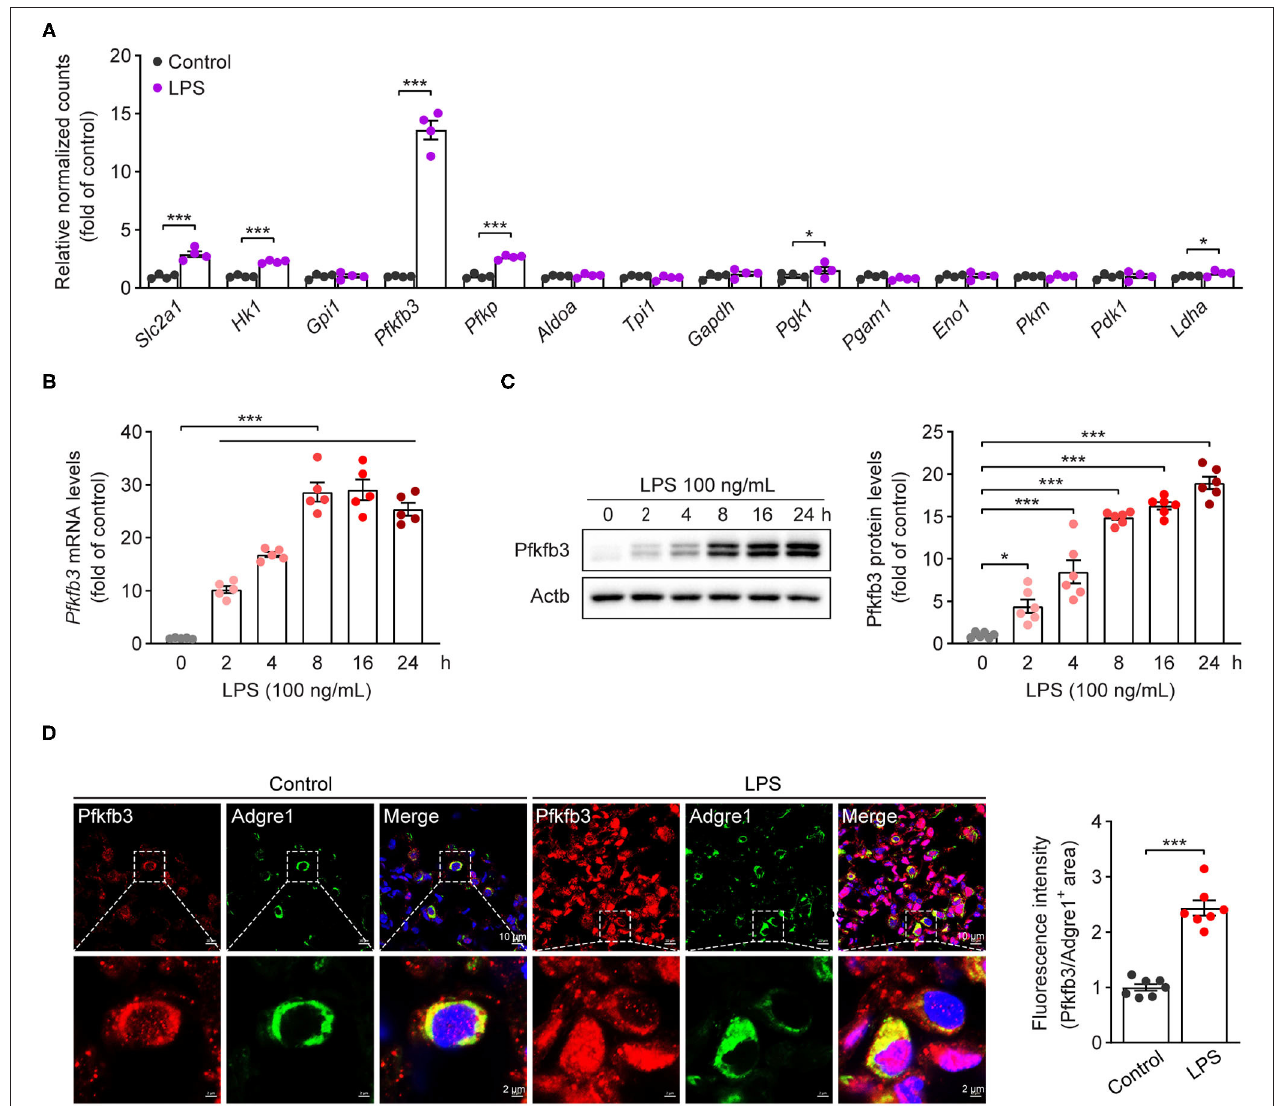
FIGURE 1 | Pfkfb3 expression is upregulated in macrophages treated with LPS. (A) The expression of glycolytic genes in BMDMs treated with LPS (100ng/mL) for 4h, the data are genome mRNA expression profiling data (GSE125036) from the GEO database ( n = 4). (B) qPCR analysis of Pfkfb3 expression in BMDMs treated with LPS (100ng/mL) for the indicated times ( n = 5). (C) Representative Western blot results of Pfkfb3 and Actb in BMDMs treated with LPS (100ng/mL) for the indicated times (left) and relative ratio of Pfkfb3/Actb (right) were quantitated by densitometric analysis of the corresponding Western blots ( n = 6). (D) Representative images (left) of triple immunofluorescence for Pfkfb3 (red), Adgre1 (green) and nuclei (DAPI, blue), and quantification (right) of Pfkfb3 expression in the pulmonary macrophages of control or LPS-treated mice ( n = 7). All data are represented as mean ± SEM, and *** P < 0.001 for indicated comparisons. Unpaired two-tailed Student’s t test for (A,D) and one-way ANOVA with Bonferroni’s post-hoc test for (B,C)